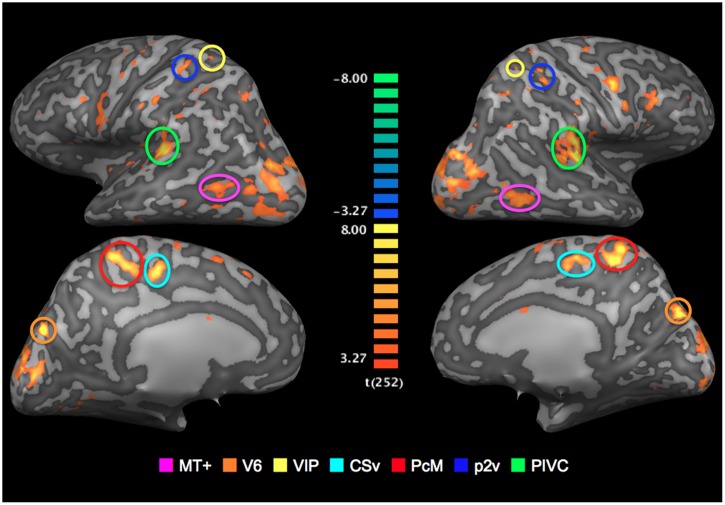
Regions of interests (ROIs): Optic-flow selective sensory regions. The map of areas that showed a significantly greater response to optic-flow stimulus than to random-motion stimulus is superimposed onto inflated representations of the left and right hemispheres of one representative brain. T-values are color-coded (see color bar). All activation shown is thresholded at p < 0.005 uncorrected.